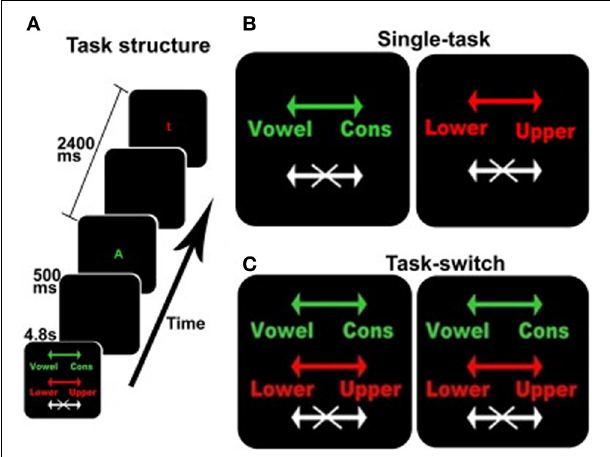
FIGURE 1 | The switching cognitive task used during fMRI scanning. (A) shows an example of the beginning of a block including the instruction screen for a task-switching block, intertrial interval, a stimulus for the vowel/consonant task, intertrial interval, and a stimulus for the upper-/lower-case task. (B,C) show the instruction screens for the single-task and the task-switching conditions, respectively. The colors served as task-cues: green for the vowel/consonant task, red for the upper-/lower-case task, and white for no-go trials. Arrows show the response-hand assignments: left for vowel/right for consonant and left for lower-case/right for